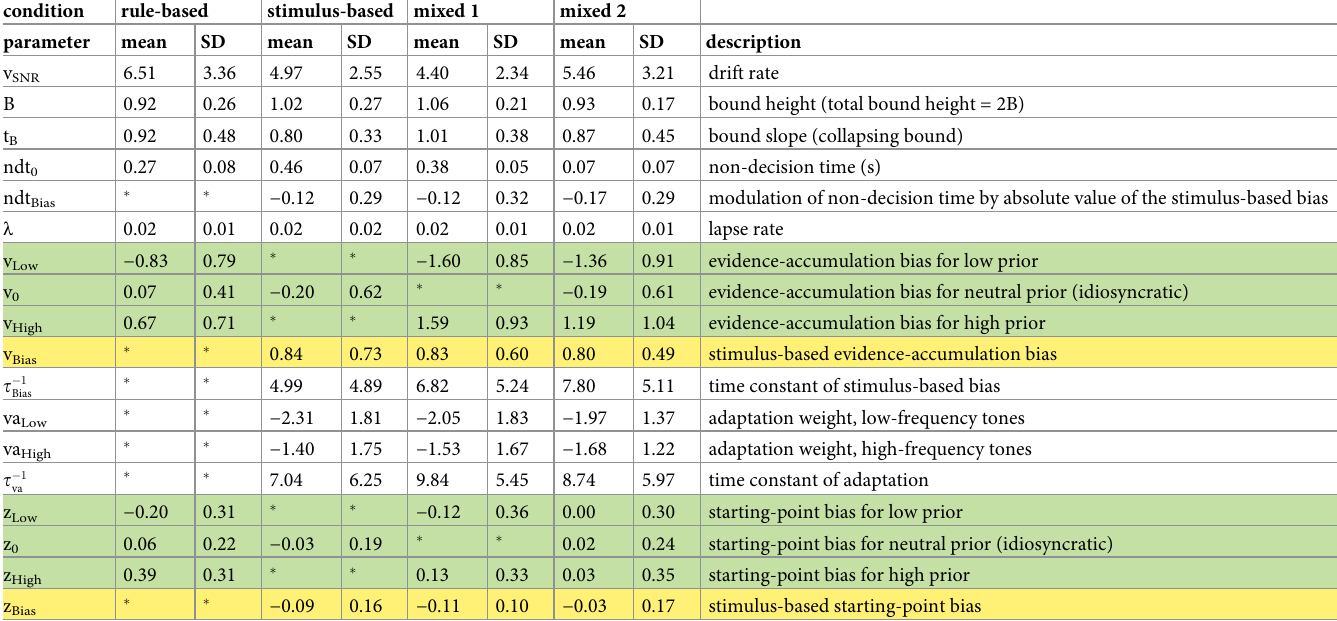
Table 4. Mean and standard deviation (SD) of best-fitting paramaters across subjects. Green rows: rule-based bias parameters; yellow rows: stimulus-based bias parameters; � parameter not present in that condition. See Methods for a fuller description of the